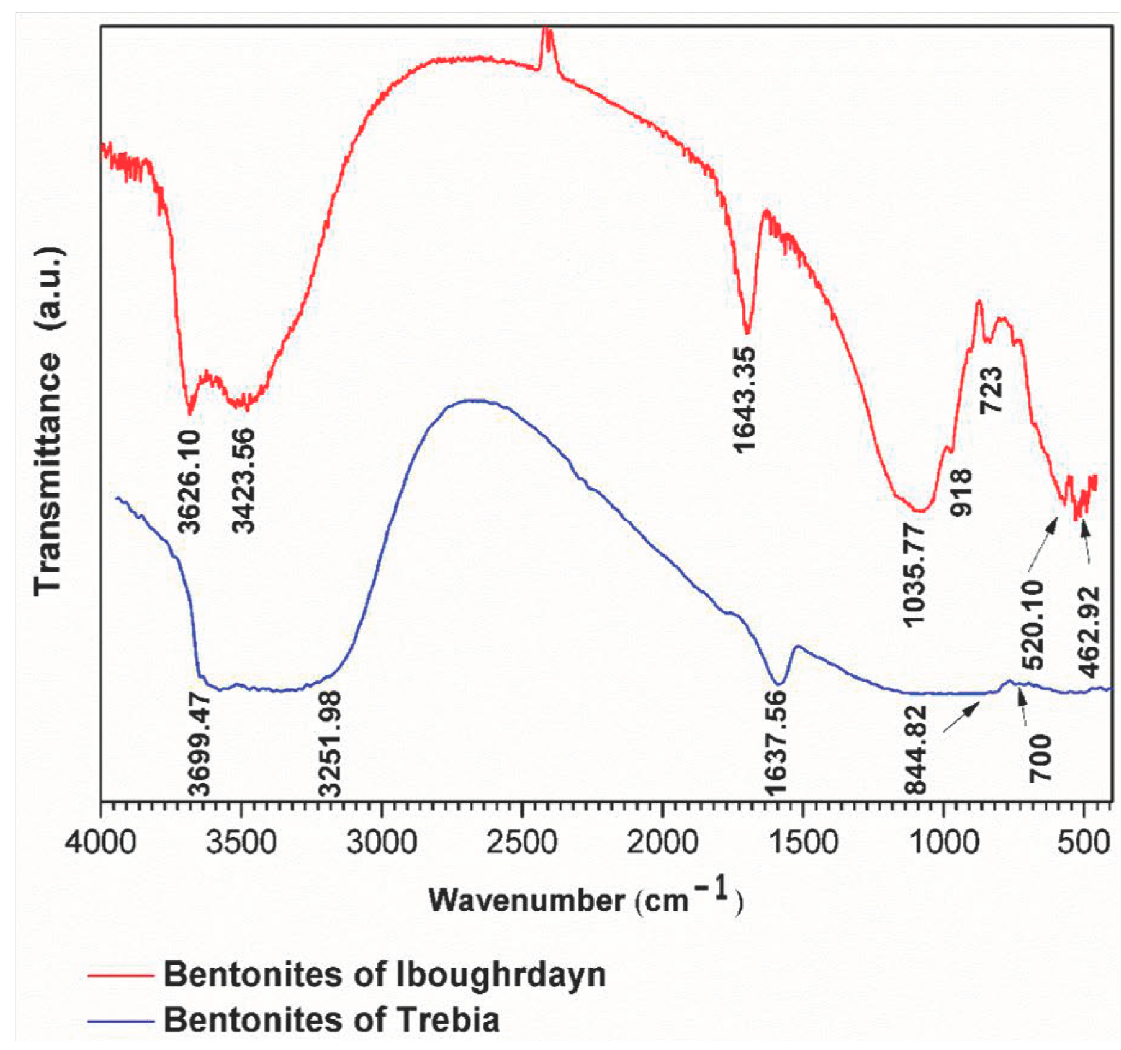
Figure 2. FTIR spectra of raw bentonite studied.